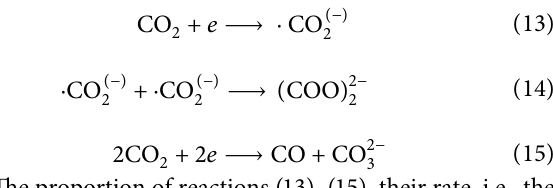
Figure 4: Schematic diagram of borate-assisted CO chemical reduction process in a U-shaped reactor from [42] under the terms of the Creative Commons CC BY